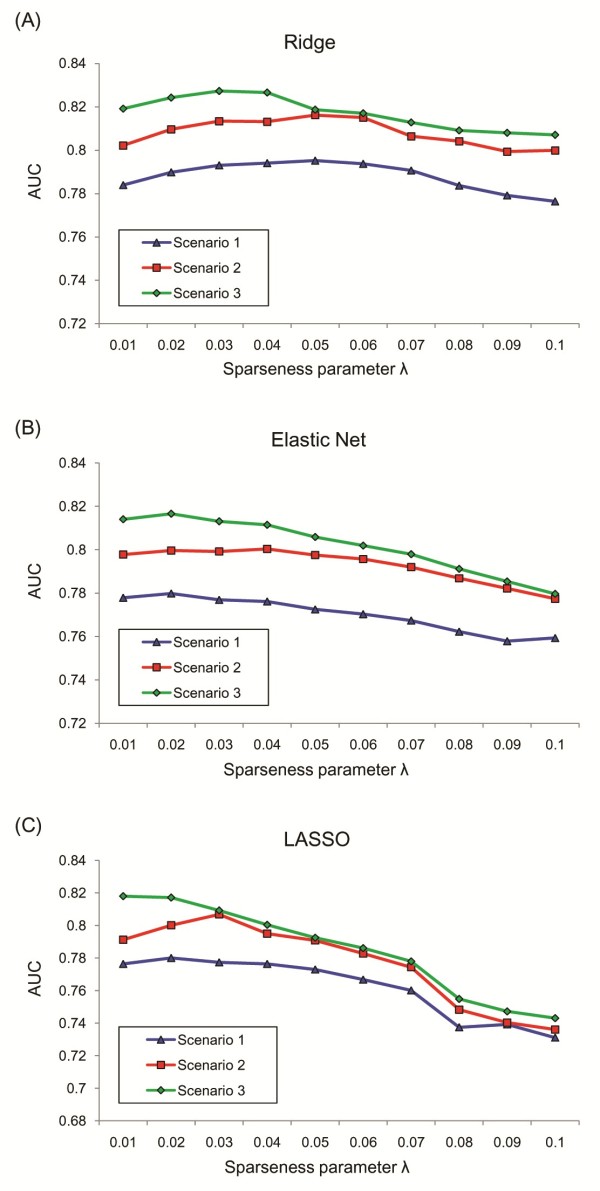
Performance (AUC) of the penalized logistic regression models using the 5-fold cross validation. The penalized logistic regression models included ridge (A), elastic net (B), and LASSO (C). In order to optimize λ, we investigated the AUC during the 5-fold cross validation as λ increased. The λ that indicated the highest AUC was chosen for the final training condition.